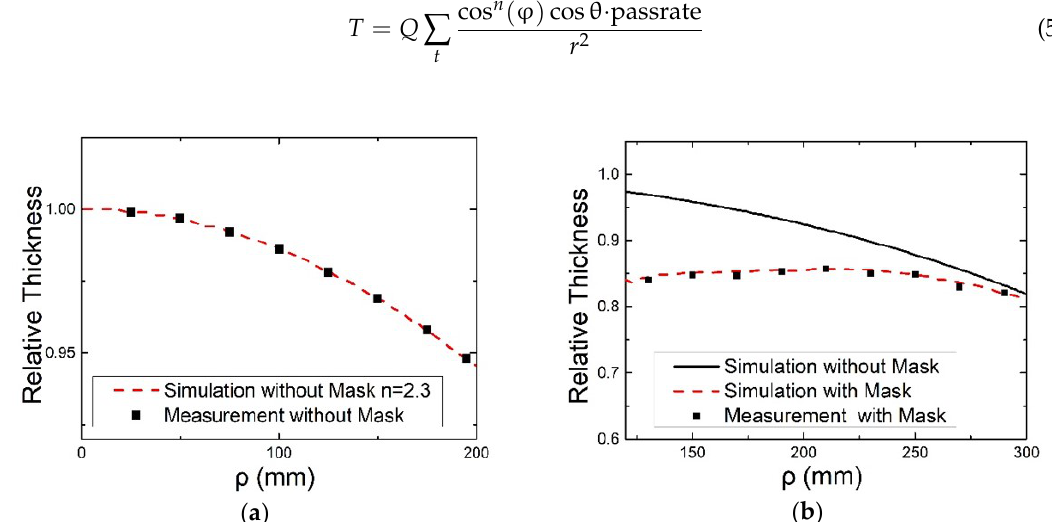
Figure 23. ( a ) The simulated depositions and measurement are used to obtain values of n , without mask; ( b ) The thickness distribution of simulation and measurement, the samples are placed from ρ = 120 and above due to the position of the rotation axis and the crystal controller.